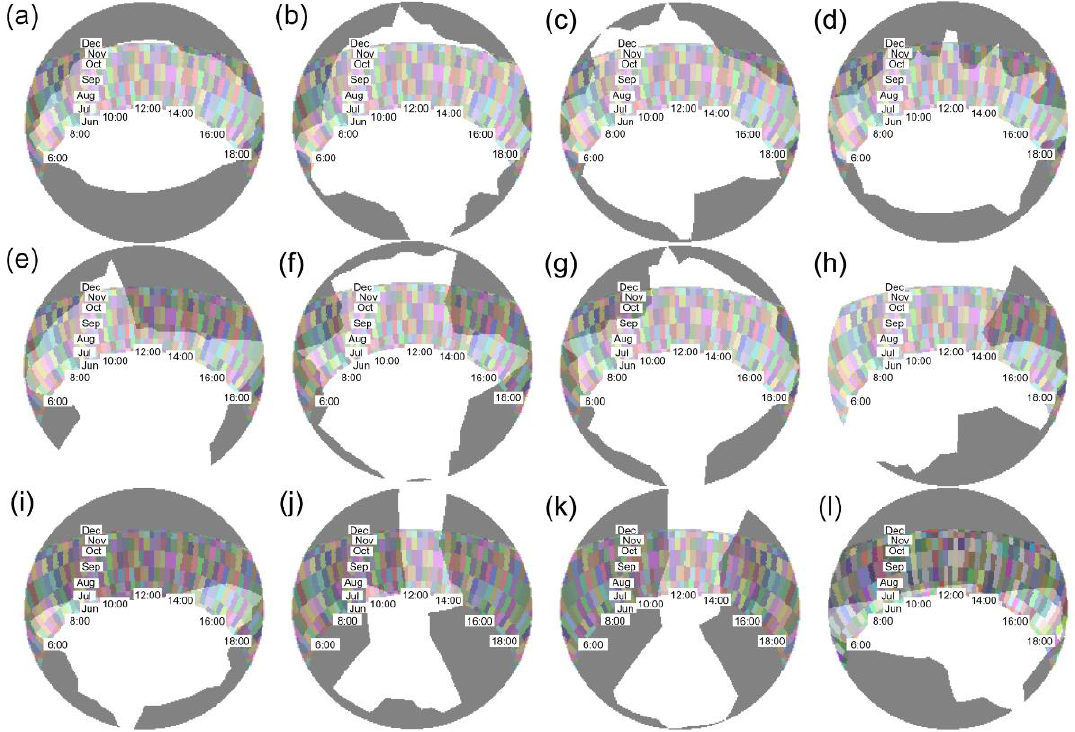
Figure 9. Skymaps generated from 3D building models overlaid by the sun-path diagram. Gray areas represent buildings around the survey points. Case A: survey points surrounded by only roadside trees ( a ) A1; ( b ) A2; ( c ) A3; ( d ) A4; Case B: survey points surrounded by buildings and trees ( e ) B1; ( f ) B2; ( g ) B3; ( h ) B4; Case C: survey points surrounded by only buildings ( i ) C1; ( j ) C2; ( k ) C3; ( l ) C4.